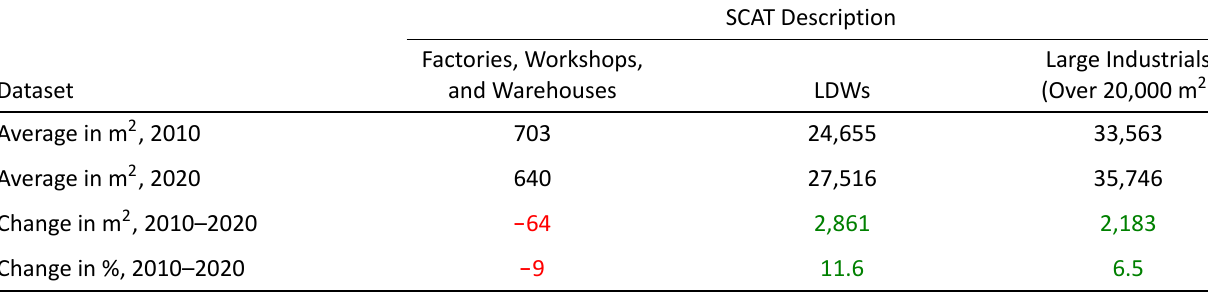
Table 2. Change in average size of industrial premises (m 2 ) by category, 2010–2020.